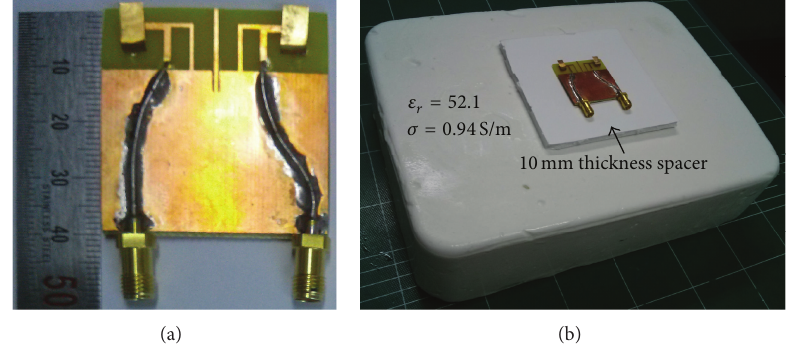
Figure 7: Fabricated antenna and measurement setup. (a) Fabricated antenna; (b) the antenna on the phantom for measurement setup.